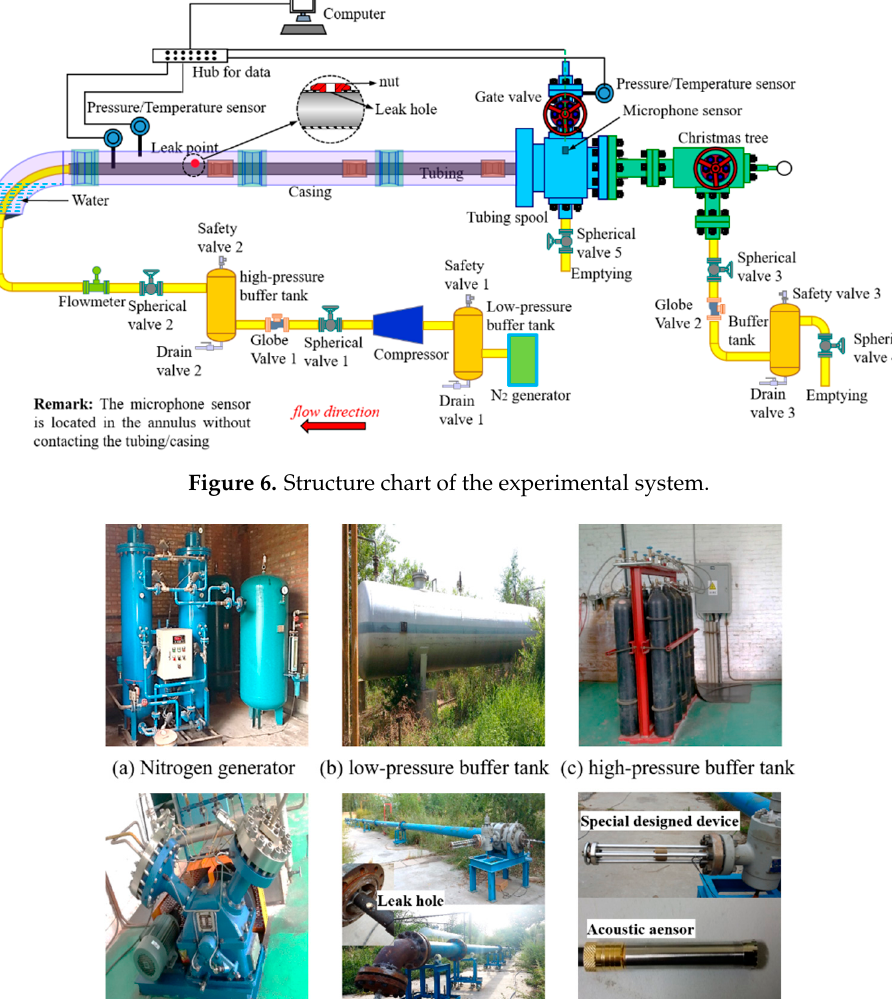
Figure 7. Pictures of the experimental system.